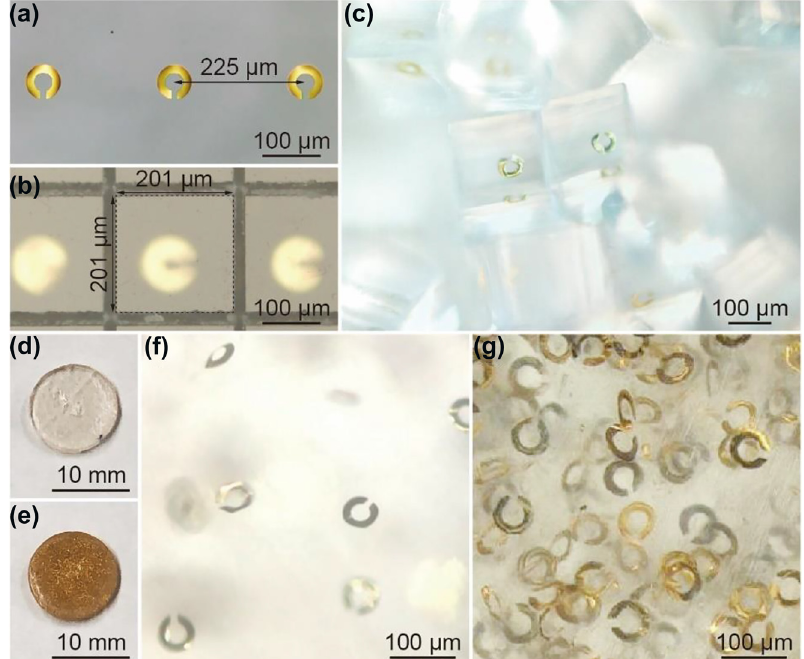
Figure 4: (a) – (c) Enlarged views of the resin sheet containing SRRs, the resin sheet